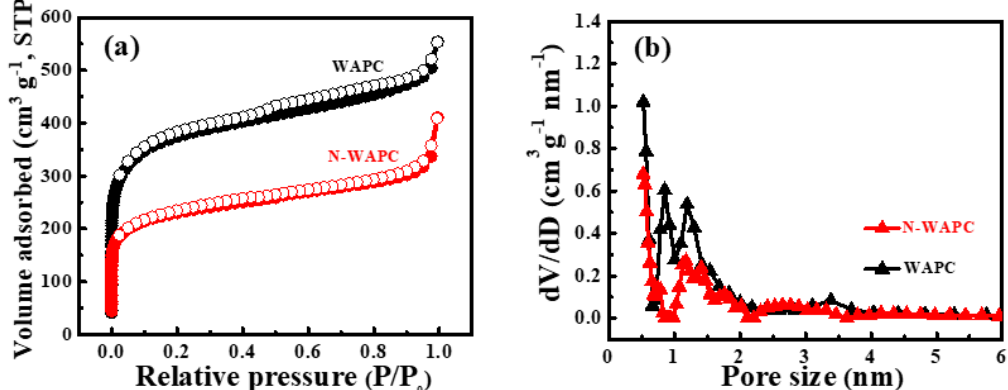
Figure 5. ( a ) N 2 adsorption–desorption isotherms and ( b ) pore size distribution (PSD) curves of WAPC and N ‐ WAPC.